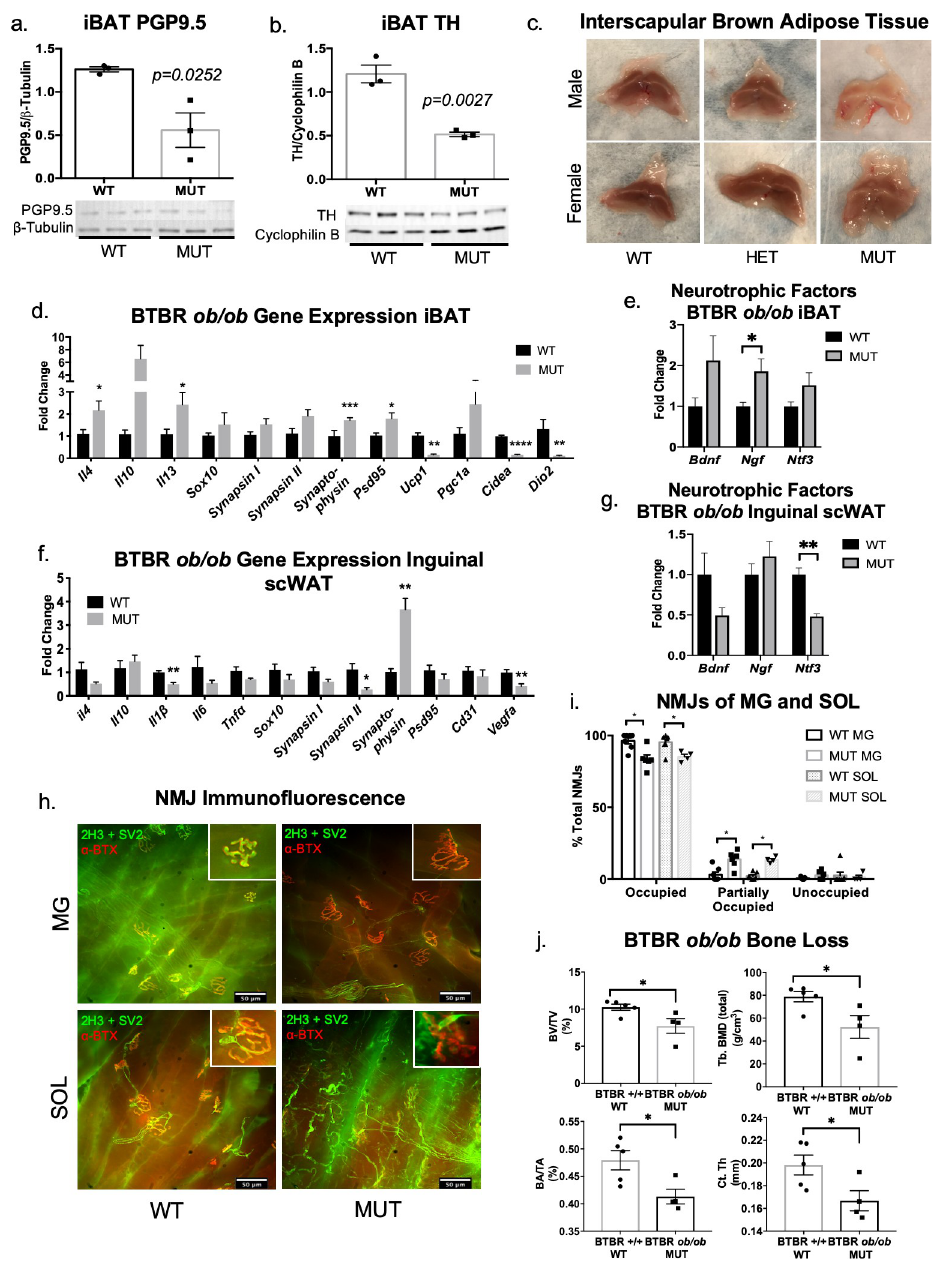
Fig 2. Neuropathy extends beyond white adipose tissue in BTBR ob/ob mice. Protein expression of PGP9.5 (a) and TH (b) in iBAT was measured in MUT mice and compared to WT littermate controls; for (a-b) all 12 week old males, N = 3 WT/MUT. For all western blots, data were normalized to housekeeper proteins β -Tubulin or Cyclophilin B, band intensities were quantified in Image J, and analyzed using a two-tailed Student’s t-test. Error bars are SEMs. Whole BAT depots were compared between female and male BTBR HET, MUT, and WT mice (c). Images are representative, males: MUT N = 2; WT N = 3; HET N = 3; females: MUT N = 1; WT N = 3; HET N = 3; all mice were 12–24 weeks old. Gene expression analysis of BAT (d-e) and inguinal scWAT (f-g). Gene expression data were analyzed by two-tailed Student’s t-test, using Welch’s correction when variance was unequal, N = 4–5 per group. Error bars are SEMs. Neuromuscular Junction (NMJ) Analysis (h-i). Immunofluorescent staining of male BTBR WT and MUT neuromuscular junctions of the medial gastrocnemius (MG) and soleus (SOL) muscles was performed using neurofilament M (2H3) and synaptic vesicles (SV2) (in green) to visualize the pre-synaptic area, and α -bungarotoxin (in red) to visualize the post-synaptic area. Representative images at 40x magnification of BTBR ob/ob wild-type (WT) medial gastrocnemius (MG) (top left panel), and soleus (bottom left panel) captured on Nikon Eclipse E400